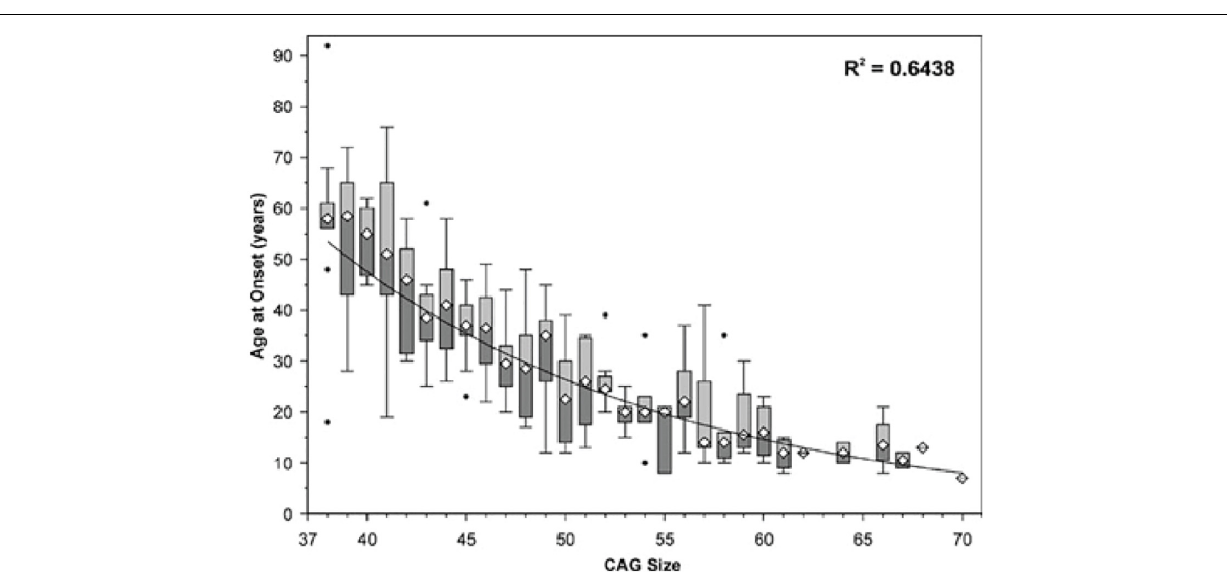
FIGURE 2 | Age of SCA7 onset vs. ATXN7 CAG repeat size. The symbol • indicates values outside the range (outliers). Adapted from Michalik et al. (2004), Spinocerebellar ataxia type 7 associated with pigmentary retinal dystrophy